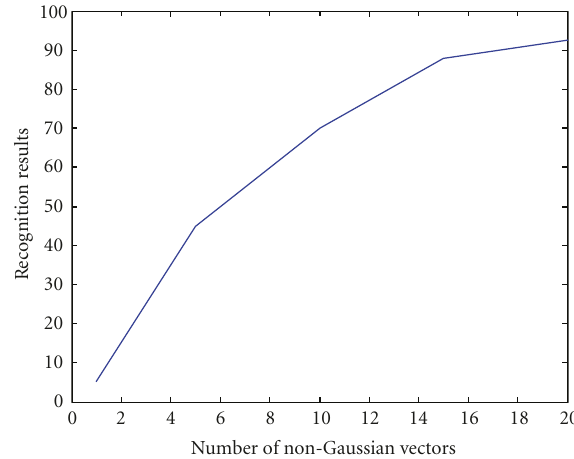
Figure 4: Recognition results for the palm as a function of the num- ber of